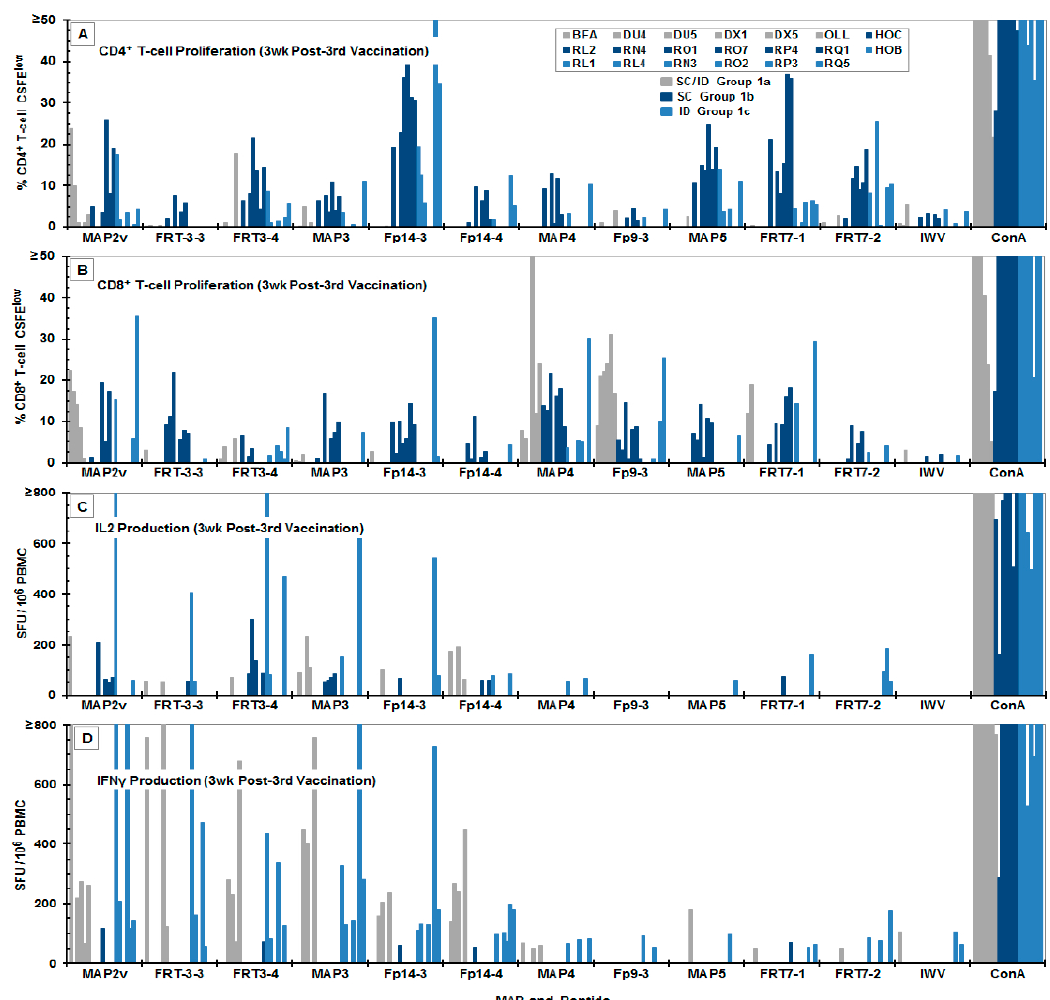
Figure 3. FIV MAP/peptide-specific T-cell proliferation and cytokine production of the PBMC from vaccinated cats at three weeks post-third vaccination. The results from CD4 + ( A ) and CD8 + ( B ) T-cell proliferation and the IL-2 ( C ) and IFN γ ( D ) production of the PBMC from the MAP-vaccinated cats are shown in response to the in vitro stimulation with MAP or FIV peptide. The vaccinated cats in Group 1a received concurrent subcutaneous plus intradermal (SC/ID) vaccinations with triple-MAP vaccine (grey bars), while those in Groups 1b and 1c received either subcutaneous (SC) (dark blue bars) or intradermal (ID) (blue bars) vaccinations with quadruplicate-MAP vaccine, respectively. The identification codes of each vaccinated cat are shown in the top right inset of panel A. Each bar represents the average response from a single vaccinated cat after subtraction of the average value of the results from eight control cats, with the exception of the mitogen control. Only bars at ≥ 0.5% CFSE low threshold for CD4 + and CD8 + T-cell proliferation or at ≥ 50 SFU/10 6 PBMC threshold for IL-2 and IFN γ production are shown.